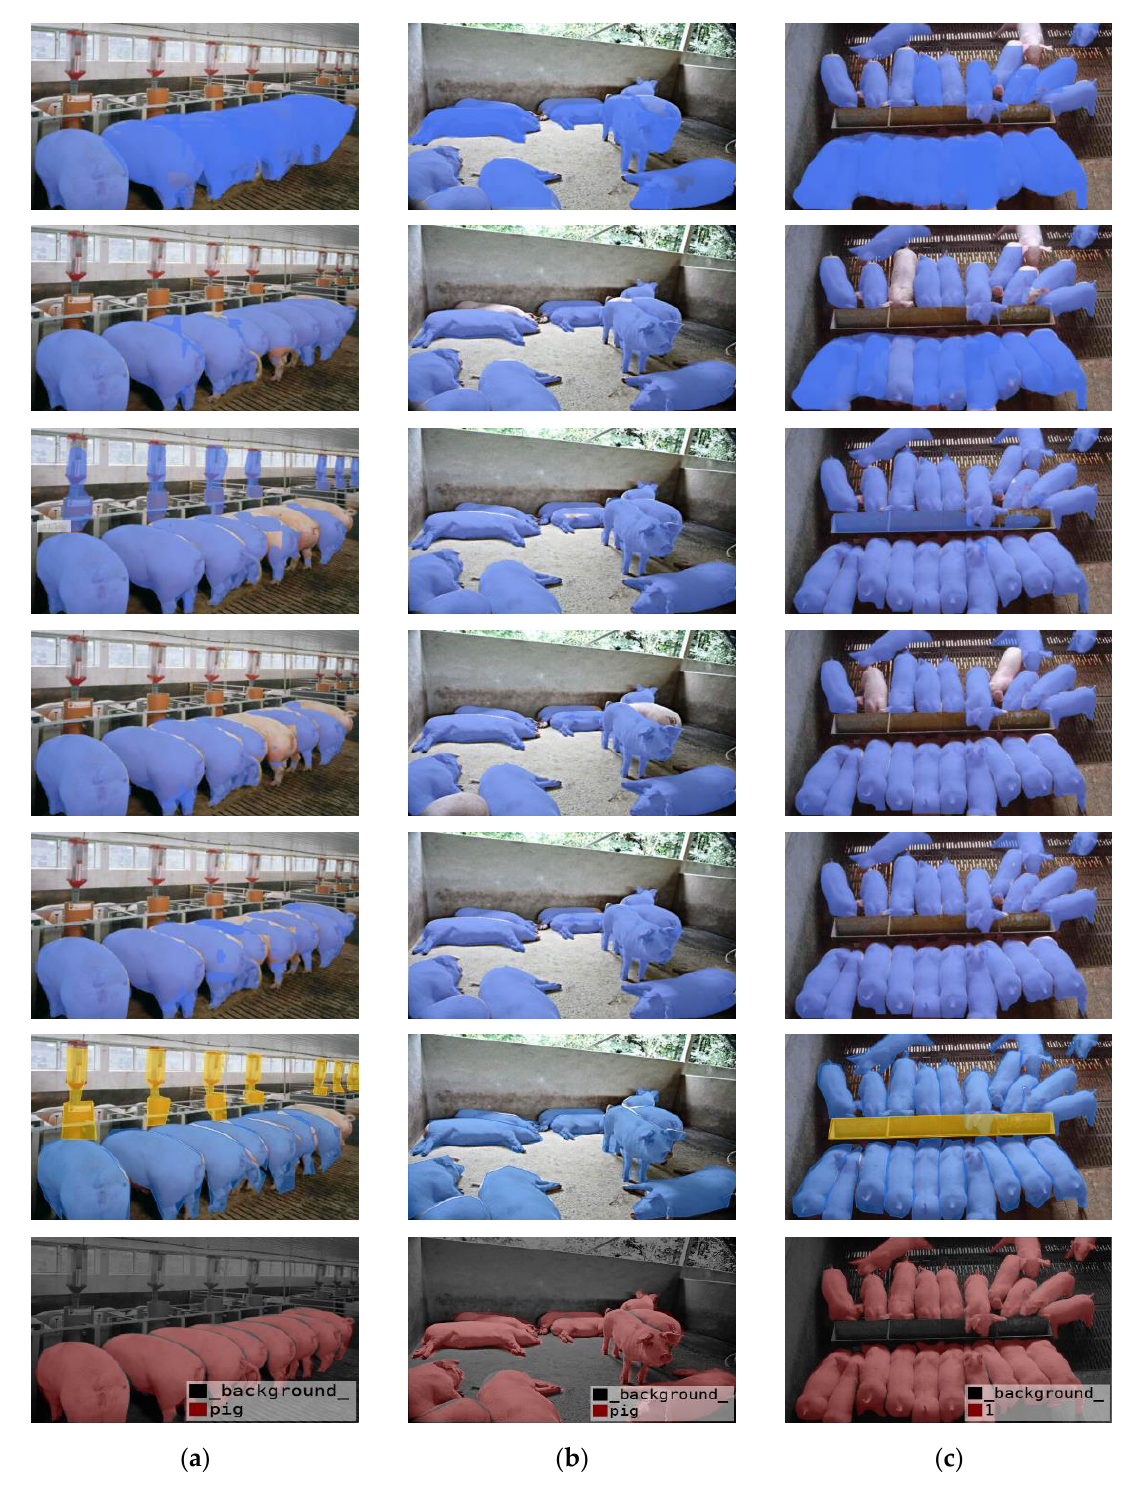
Figure 10. Comparison results of different segmentation models: ( a ) lightweight image; ( b ) mid- dleweight image; ( c ) heavyweight image.